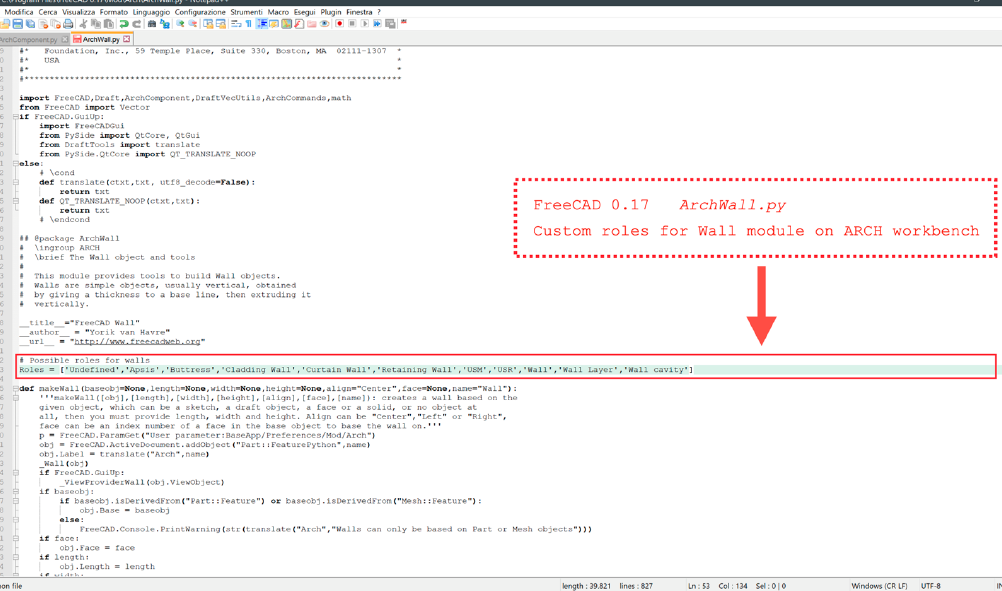
Figure 2. Access and modification of ArchWall.py Python file by using FreeCAD 0.17: highlighted in green are customized and possible roles for wall entity and related attributes below.